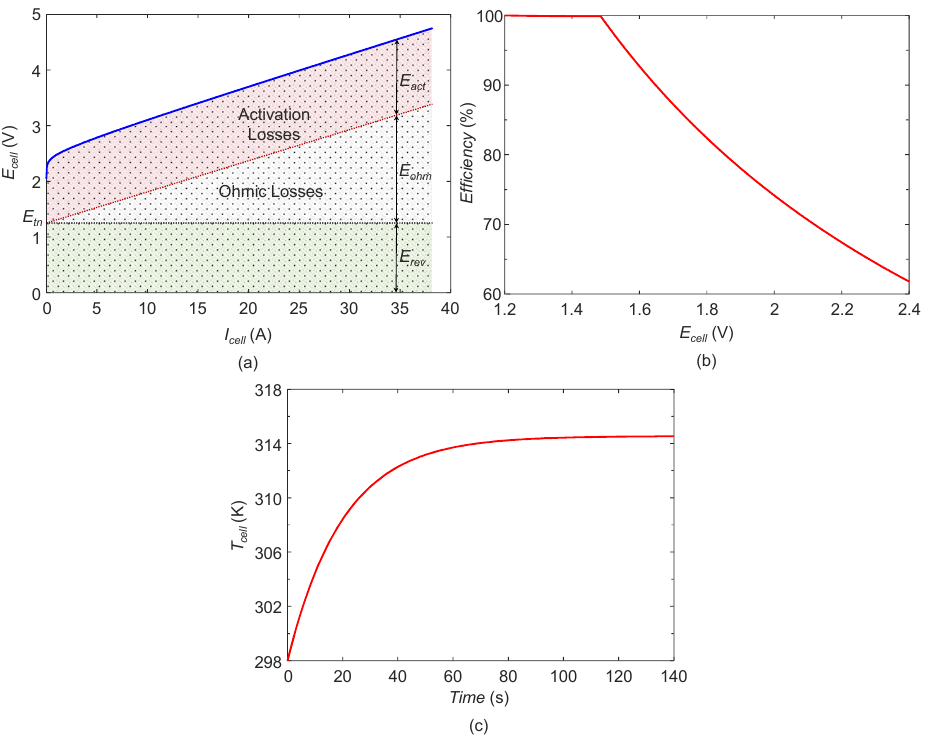
Figure 22. ( a ) Contribution of overvoltages, ( b ) efficiency of electrolysis cell and ( c ) temperature evolution of